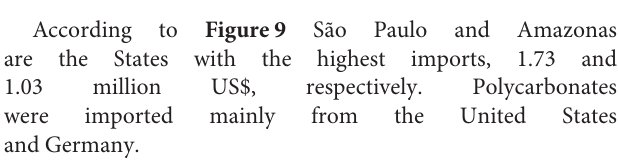
FIGURE 11 | Acetaldehyde imports. (A) Local needs considering 2017; (B) Stratification for 2017, countries on the left represent the origin of the product studied and the states on the right represent the destination (AM, Amazonas; GO, Goiás; PR, Paraná; RS, Rio Grande do Sul; SC, Santa Catarina; SP, São Paulo).